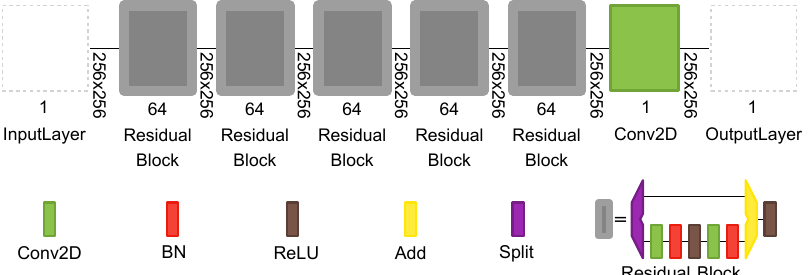
Figure 5. The proposed Noise Estimation Subnetwork NE-SNet composed of residual learning blocks.